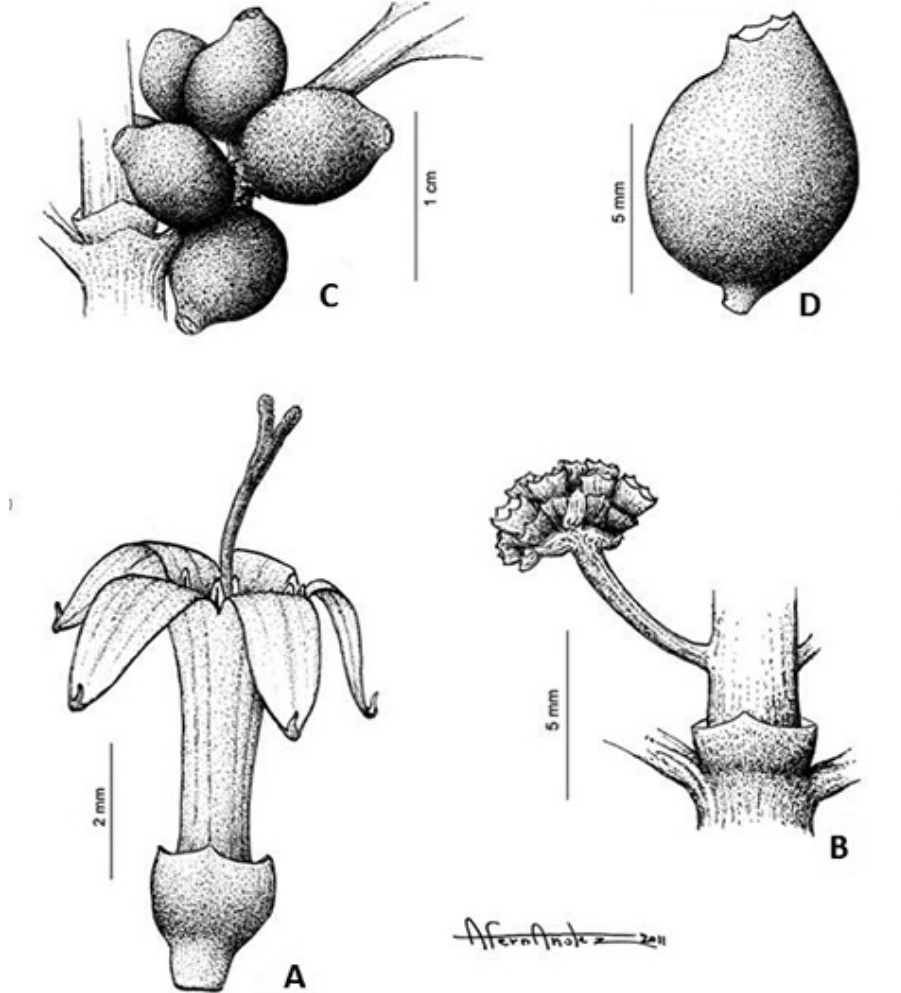
Figure 1. Craterispermum capitatum . A Longistylous flower B Node with stipules and inflorescences (only one shown) C Node with infrutescence with young fruits D Young fruit. A from Trochain 8306 (P) B from Richards 3382 (MO) C, D from Louis 9162 (BR). Drawn by Antonio Fernandez. paler green below; base cuneate; apex acuminate, acumen 7–10 mm long;